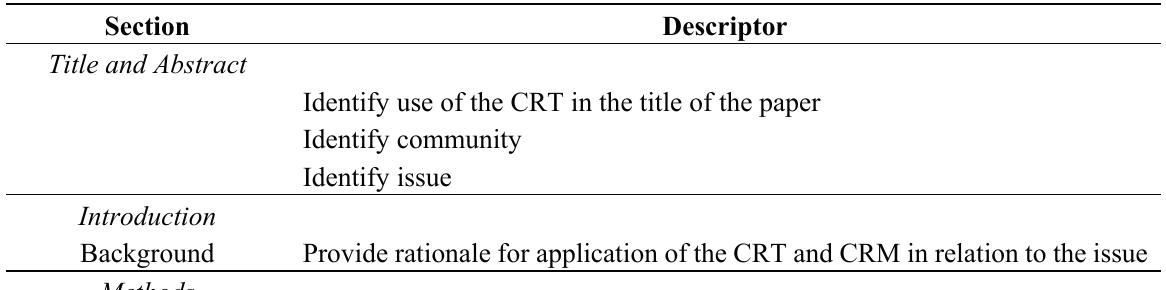
Table 3. Reporting recommendations for primary studies which apply the community readiness tool